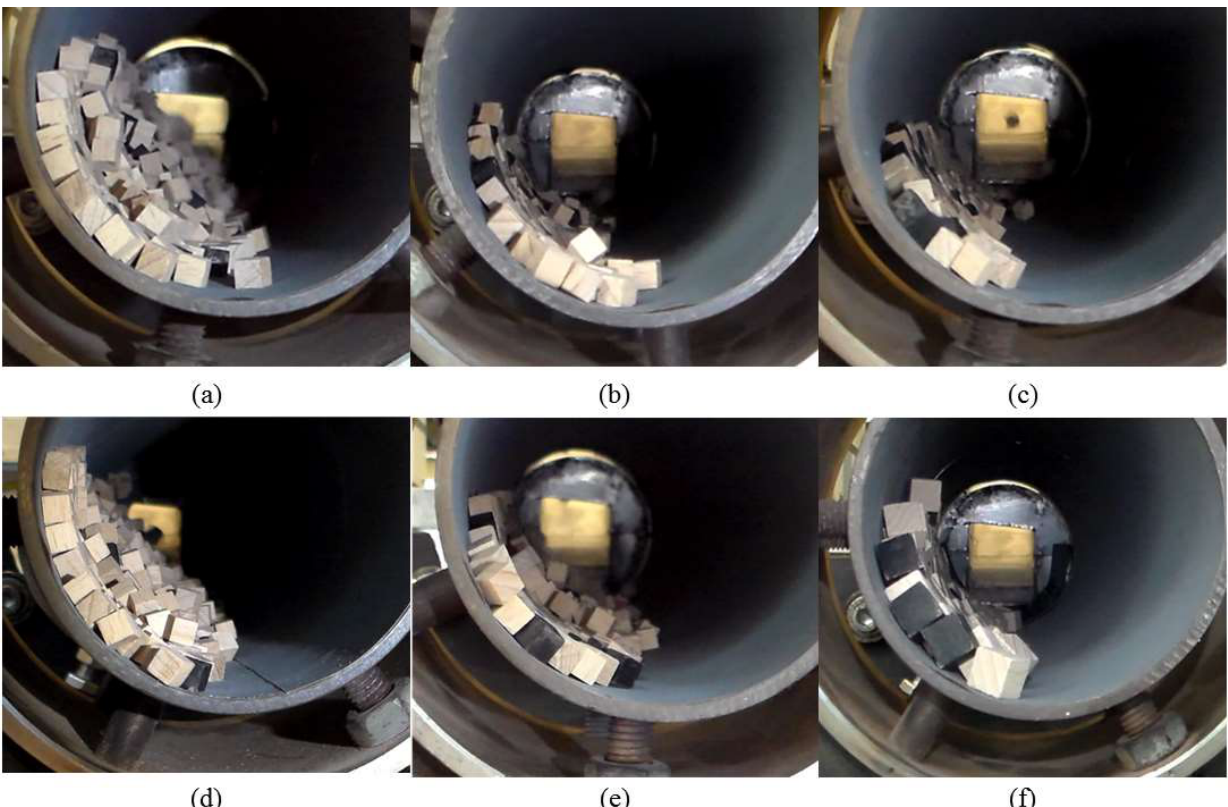
Figure 3 . Cross view of drum at ( a ) 3 rpm, 3°, and 1.08 cm 3 /s for 6 mm cubes ( b ) 7 rpm, 3°, and 1.08 cm 3 /s for 6 mm cubes ( c ) 11 rpm, 3°, and 1.08 cm 3 /s for 6 mm cubes ( d ) 3 rpm, 2°, and 1.08 cm 3 /s for 1.08 cm 3 /s for 6 mm cubes ( c ) 11 rpm, 3 ◦ , and 1.08 cm 3 /s for 6 mm cubes ( d ) 3 rpm, 2 ◦ , and 1.08 cm 3 /s 6 mm cubes ( e ) 3 rpm, 3°, and 0.67 cm 3 /s for 6 mm cubes ( f ) 3 rpm, 3°, and 1.08 cm 3 /s for 10 mm for 6 mm cubes ( e ) 3 rpm, 3 ◦ , and 0.67 cm 3 /s for 6 mm cubes ( f ) 3 rpm, 3 ◦ , and 1.08 cm 3 /s for 10 mm cubes (black particles are tracer). cubes (black particles are